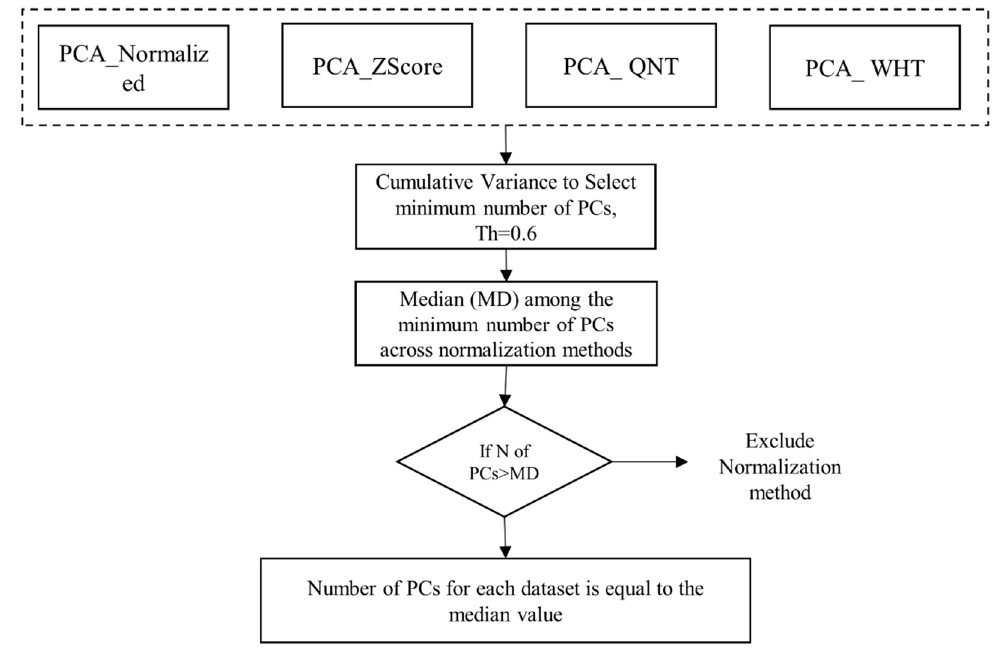
Figure 2. Workflow for PC reduction. PCA: principal component analysis; QNT: quantile normalization method; WHT: whitening normalization method; PCs: principal components; Th: threshold; MD: median.